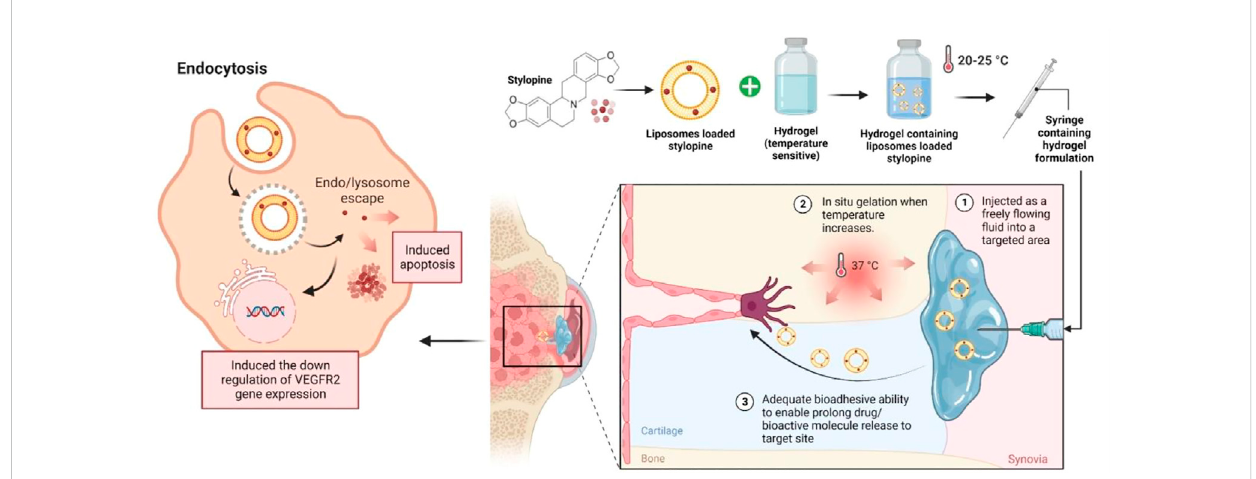
Future perspective of thermoresponsive hydrogel embedded liposomal stylopine for the management of osteosarcoma. Abbreviations: VEGFR2; Vascular endothelial growth factor receptor